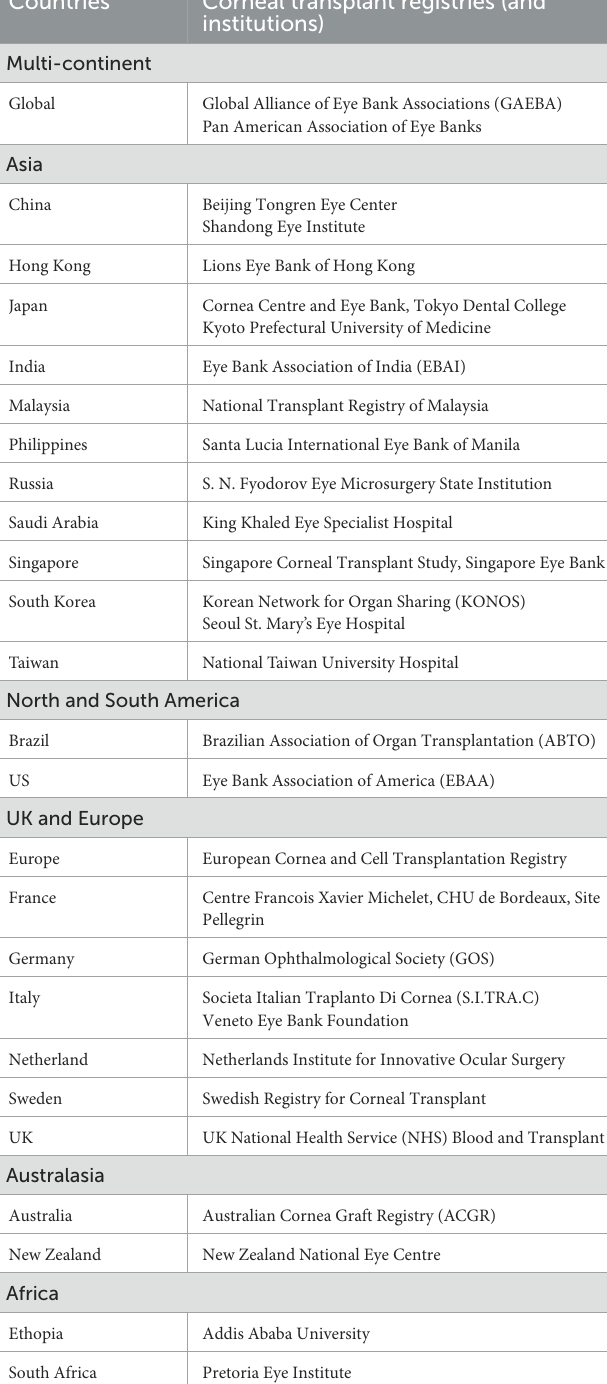
TABLE 1 Summary of main corneal transplant registries and institutions in the world, categorized by continents. Countries Corneal transplant registries (and institutions)